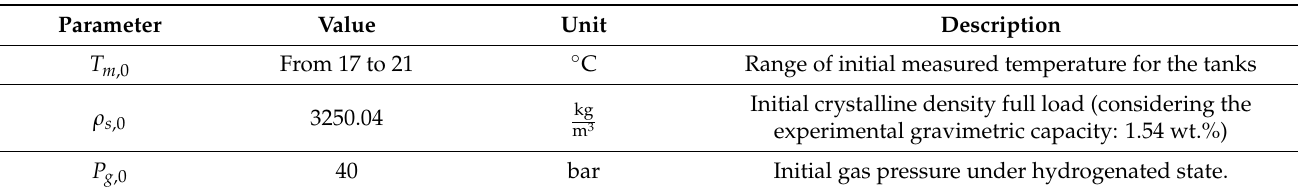
Table 3. Initial parameters for the MH-system.